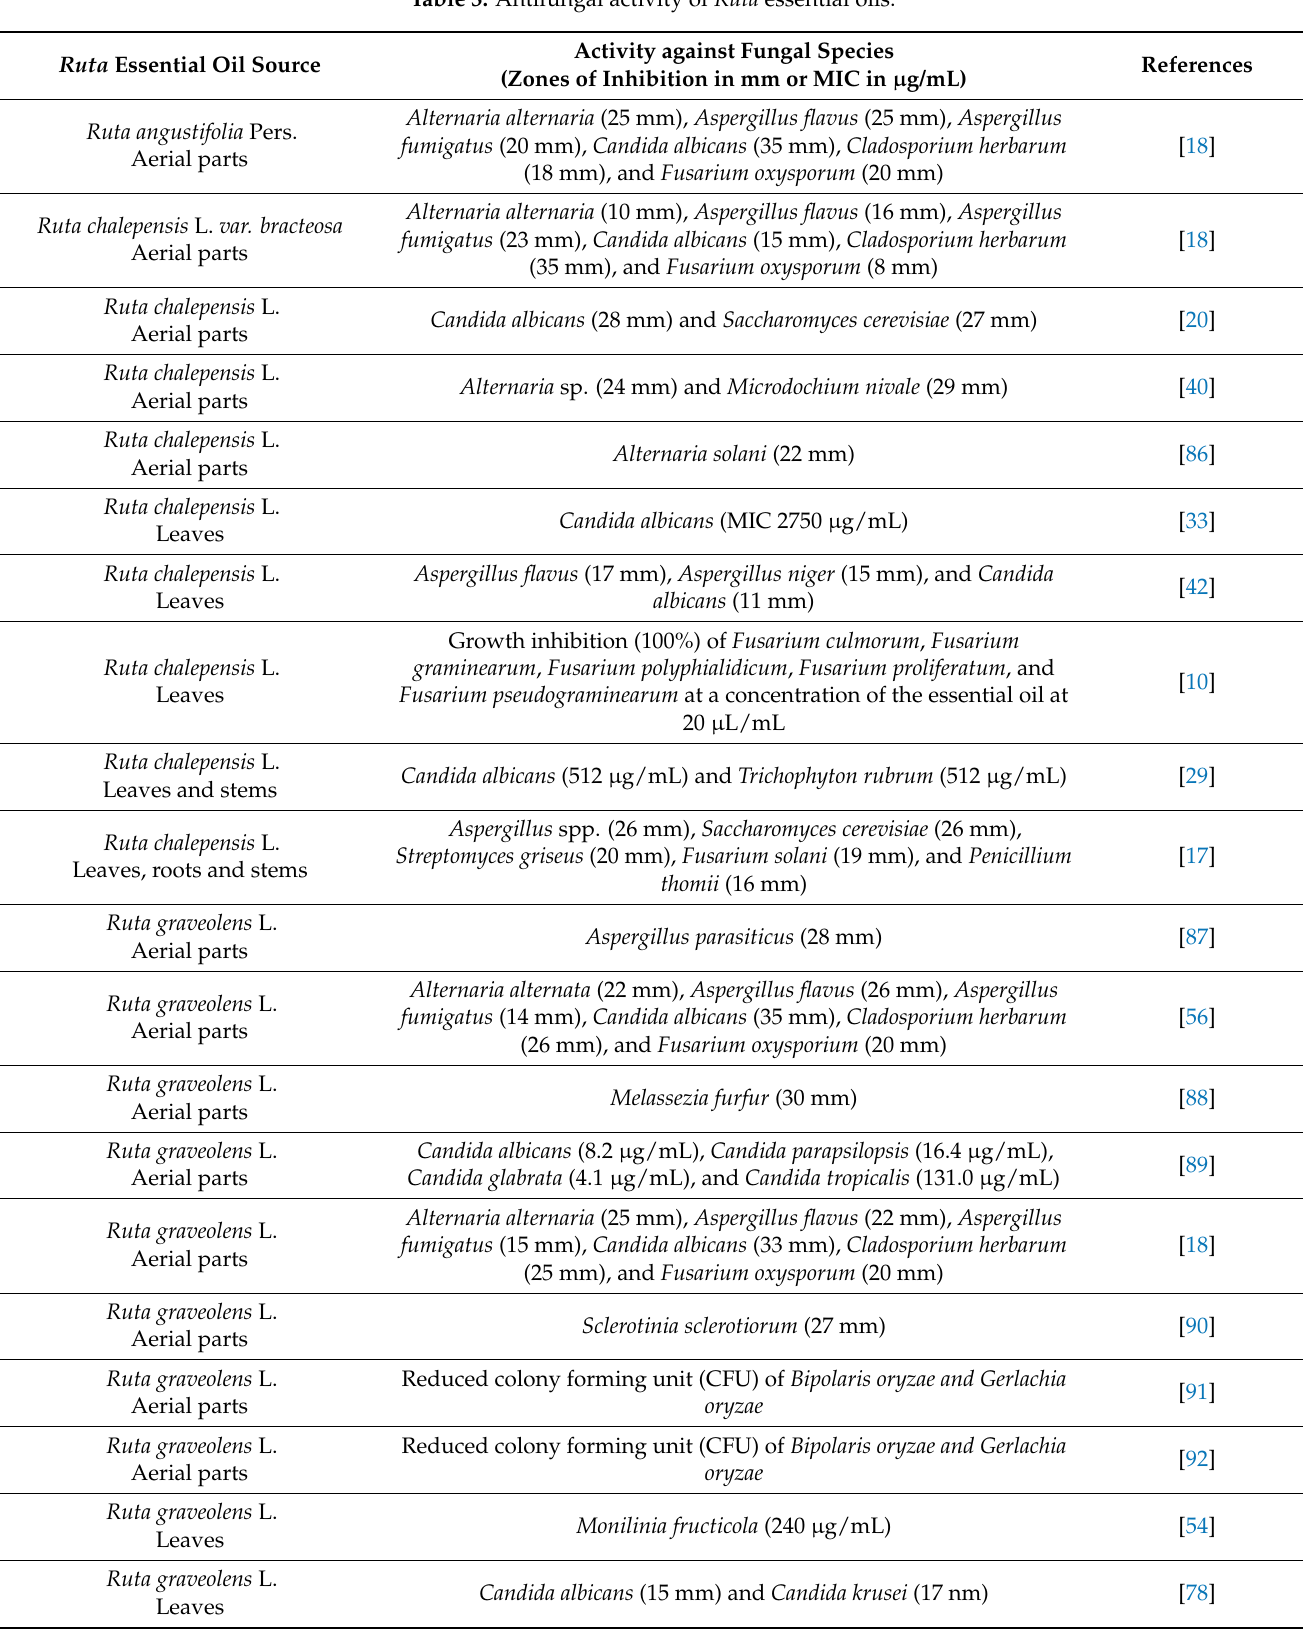
Table 3. Antifungal activity of Ruta essential